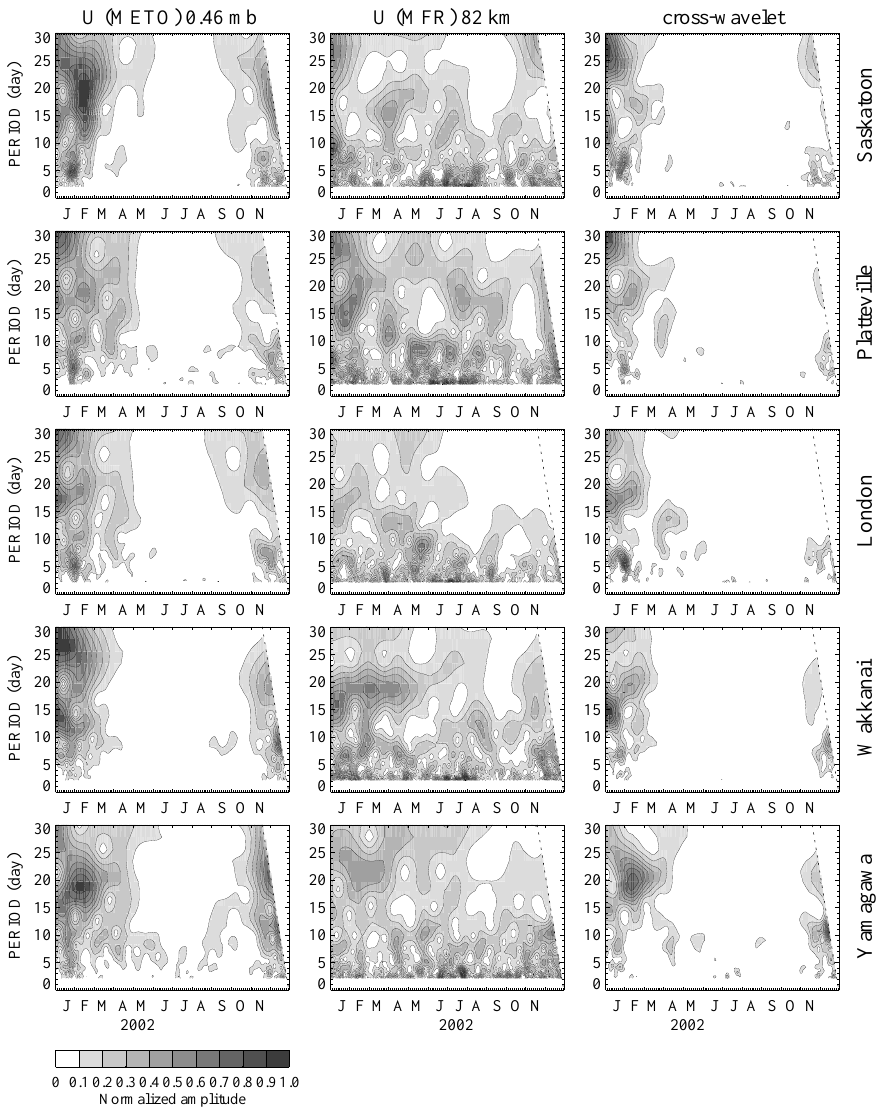
Fig. 7. ( b ) The same as Fig. 6b, but for the year 2002.